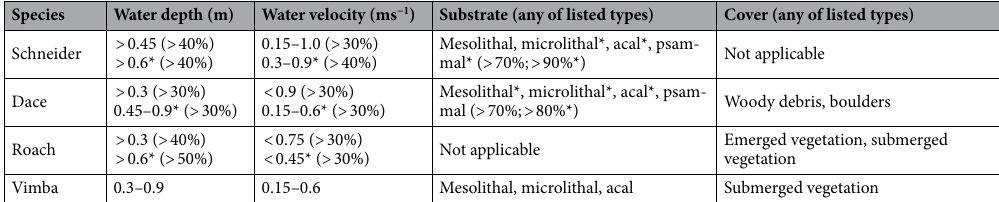
Table 2. Conditional habitat suitability criteria for selected species. Star symbol (*) indicates abundance criteria. The percentage in parentheses indicates the minimum area of the HMU that must meet the criteria.